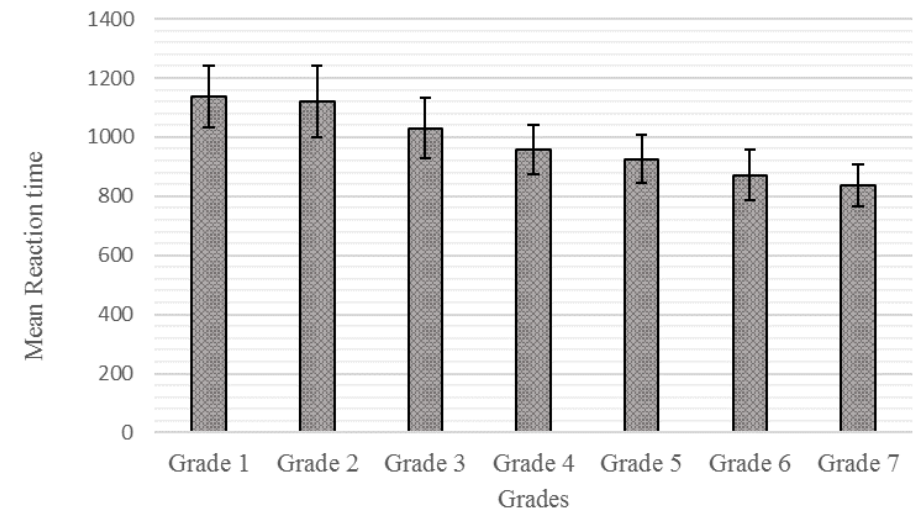
Figure 2. Mean and standard deviation for reaction time from Grade I to Grade